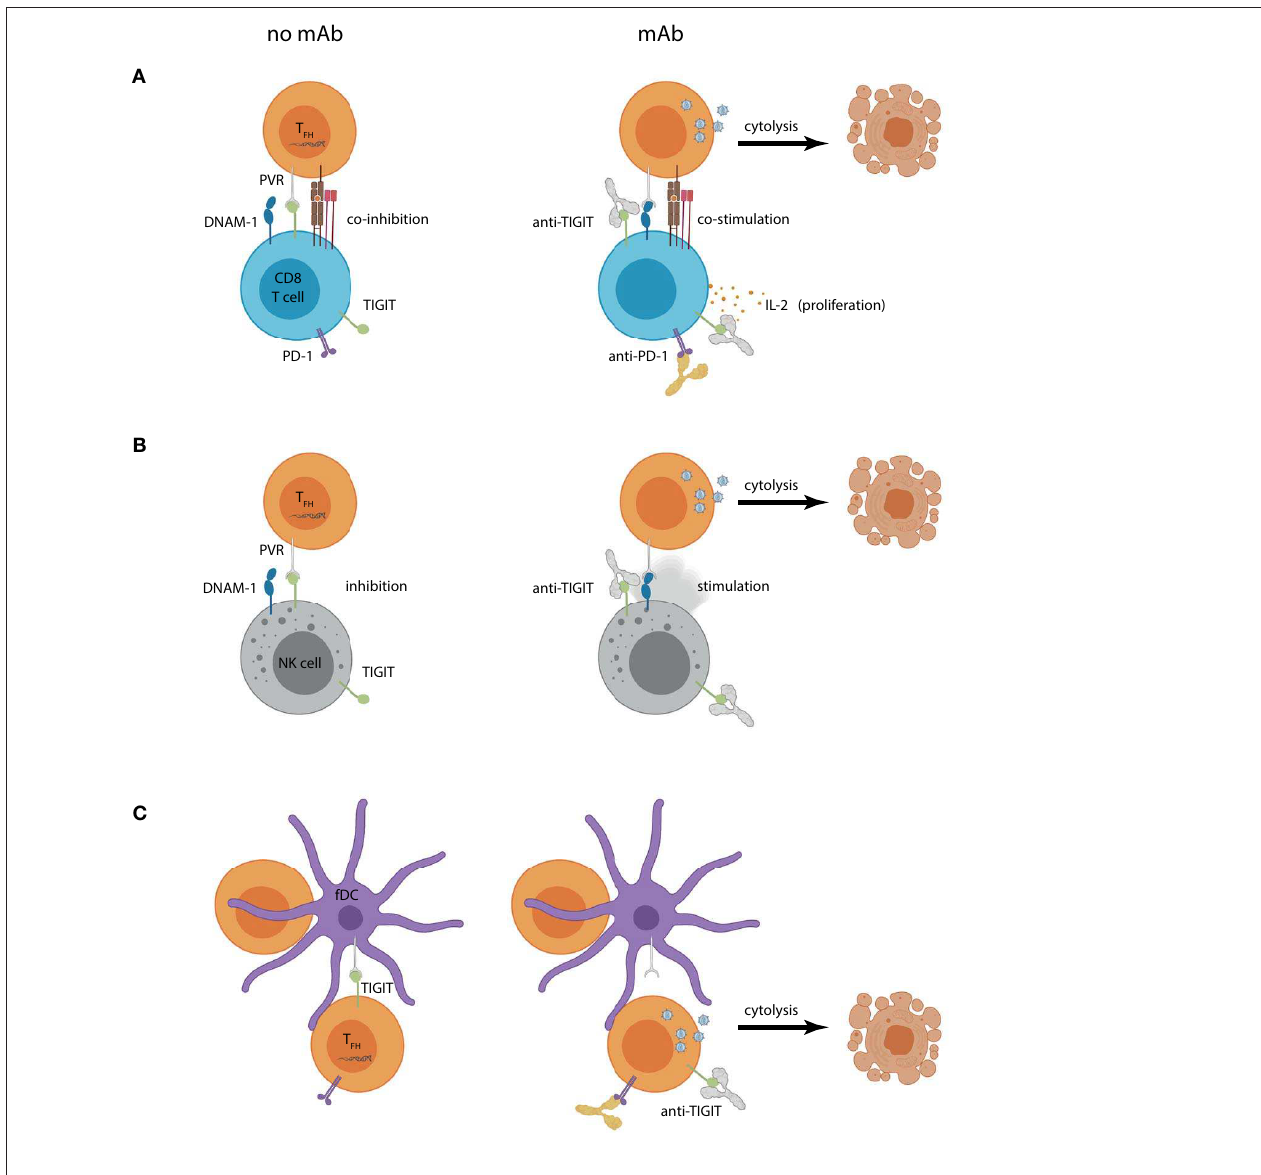
FIGURE 2 | Hypothetical outcomes of using TIGIT blockade within a “shock and kill” approach for HIV-1 curative therapy. Increased PVR expression on lymph node CD4 + T FH cells can contribute to (A) CD8 + T cell or (B) NK cell dysregulation by engaging TIGIT and (co)inhibiting effector functions (left panel). Combined CD4 + T cell reservoir activation and TIGIT mAb (right panel) could create a scenario where previously latent HIV-1 actively replicates, introducing targets for HIV-1-specific CD8 + T cell or NK cell recognition. Reservoir cytolysis is promoted in this scenario by preventing inhibitory TIGIT interactions and allowing DNAM-1 (co)stimulation. Combination TIGIT and PD-1 mAbs would also allow CD8 + T cell proliferation and IL-2 production. (C) Follicular DCs (fDCs) express PVR and interact closely with reservoir CD4 + T cells. TIGIT is also expressed on lymph node CD4 + T cells and may contribute to their suppression (left panel). Humanized anti-TIGIT mAb could aid in “shock”ing latent cells into productive infection by preventing CD4 + T FH cell TIGIT interactions with PVR expressed on fDCs leading to virus-induced or effector cell mediated